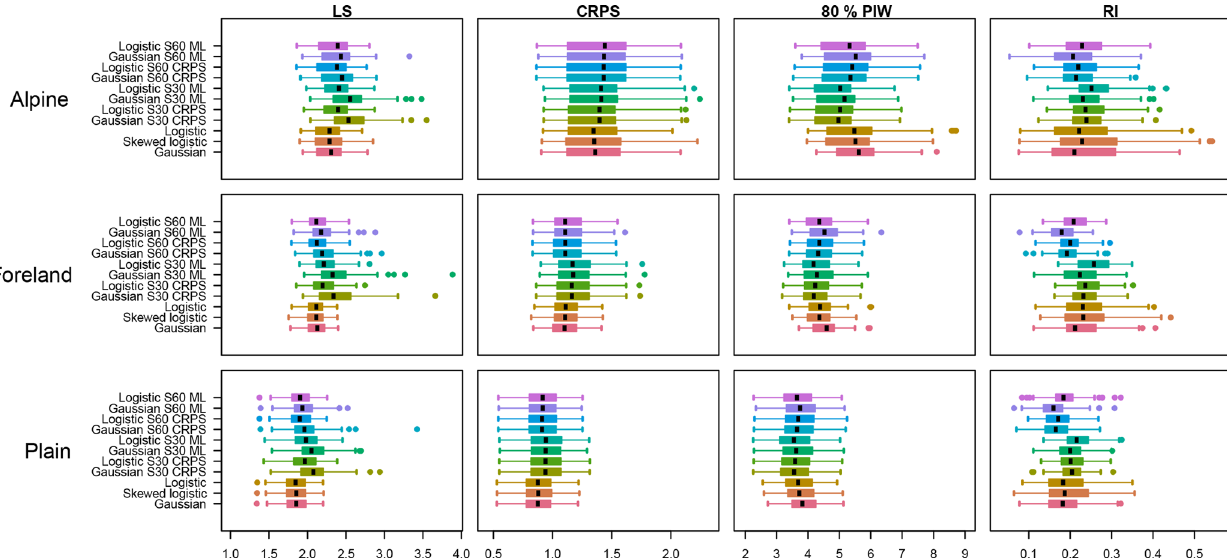
Figure 8. Performance measures in terms of LS, CRPS, 80% PIW, and RI (left to right), clustered for Alpine, foreland, and plain sites (top to bottom), and were only evaluated on 2015 for out-of-sample comparison. The box and whiskers are based on average scores for each station and lead time, with boxes illustrating the interquartile range (0.25–0.75), whiskers displaying the ± 1 . 5 times interquartile range, and solid circles representing outliers. Sliding training window models are labeled as S60 and S30 denoting a 60 or 30d training period, respectively. Additionally, the optimization score used is labeled as CRPS or ML (continuous ranked probability score or maximum likelihood), respectively.